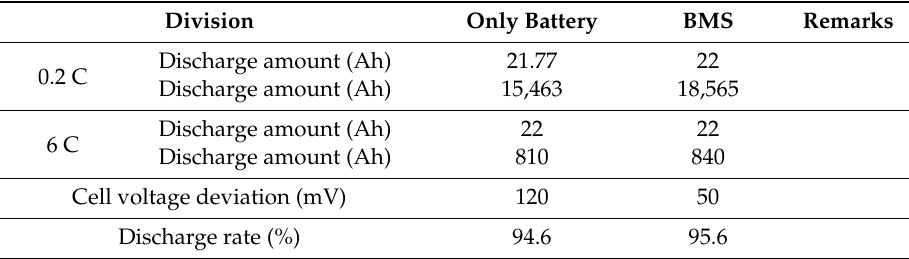
Table 6. Comparing the discharge of the battery alone versus that with the battery management system (BMS).